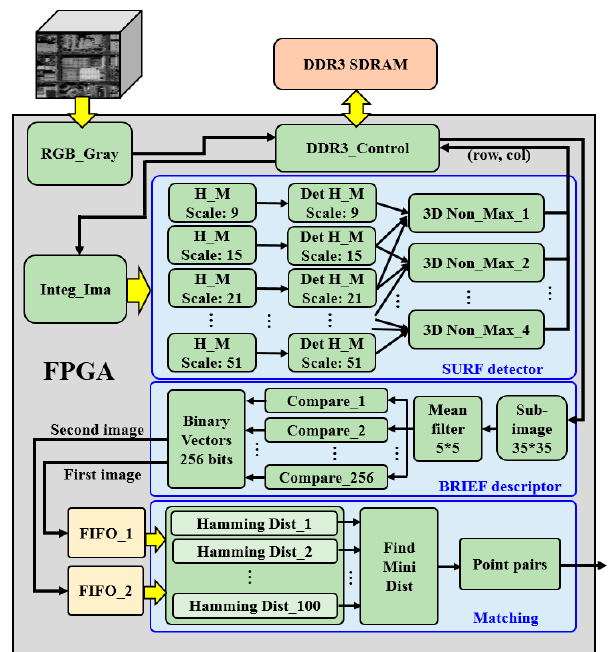
Figure 3. Hardware architecture of FPGA-based detection and matching.